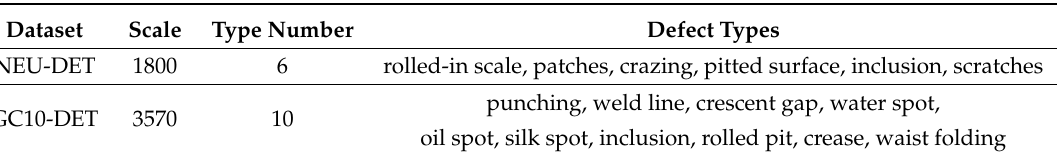
Table 1. Comparison of NEU-DET and GC10-DET